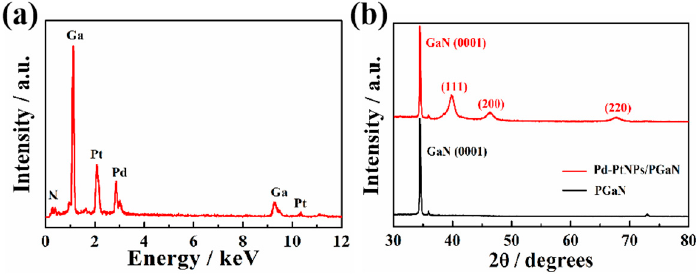
Figure 3. ( a ) EDS spectrum of the Pd-Pt/PGaN electrode. ( b ) XRD patterns of the PGaN and Pd-Pt/PGaN electrodes. Pd-Pt/PGaN